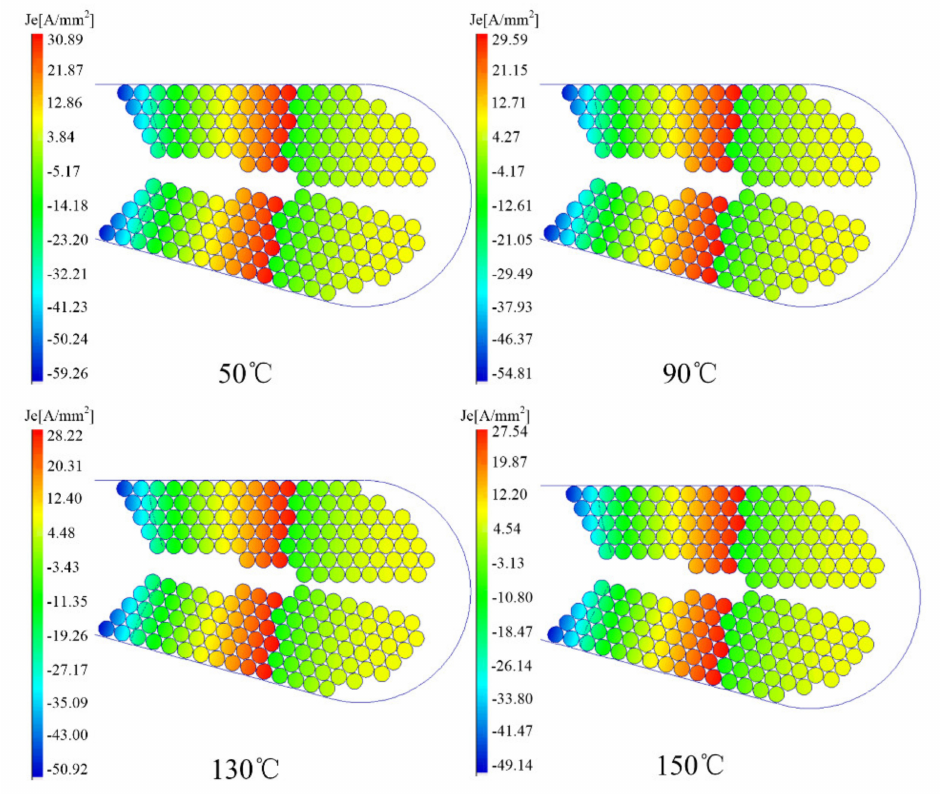
Figure 24. Current density with temperature when the conductor diameter is 0.75 mm. Figure 25 analyzes the trends of DC copper loss and AC/DC loss ratio k ac at